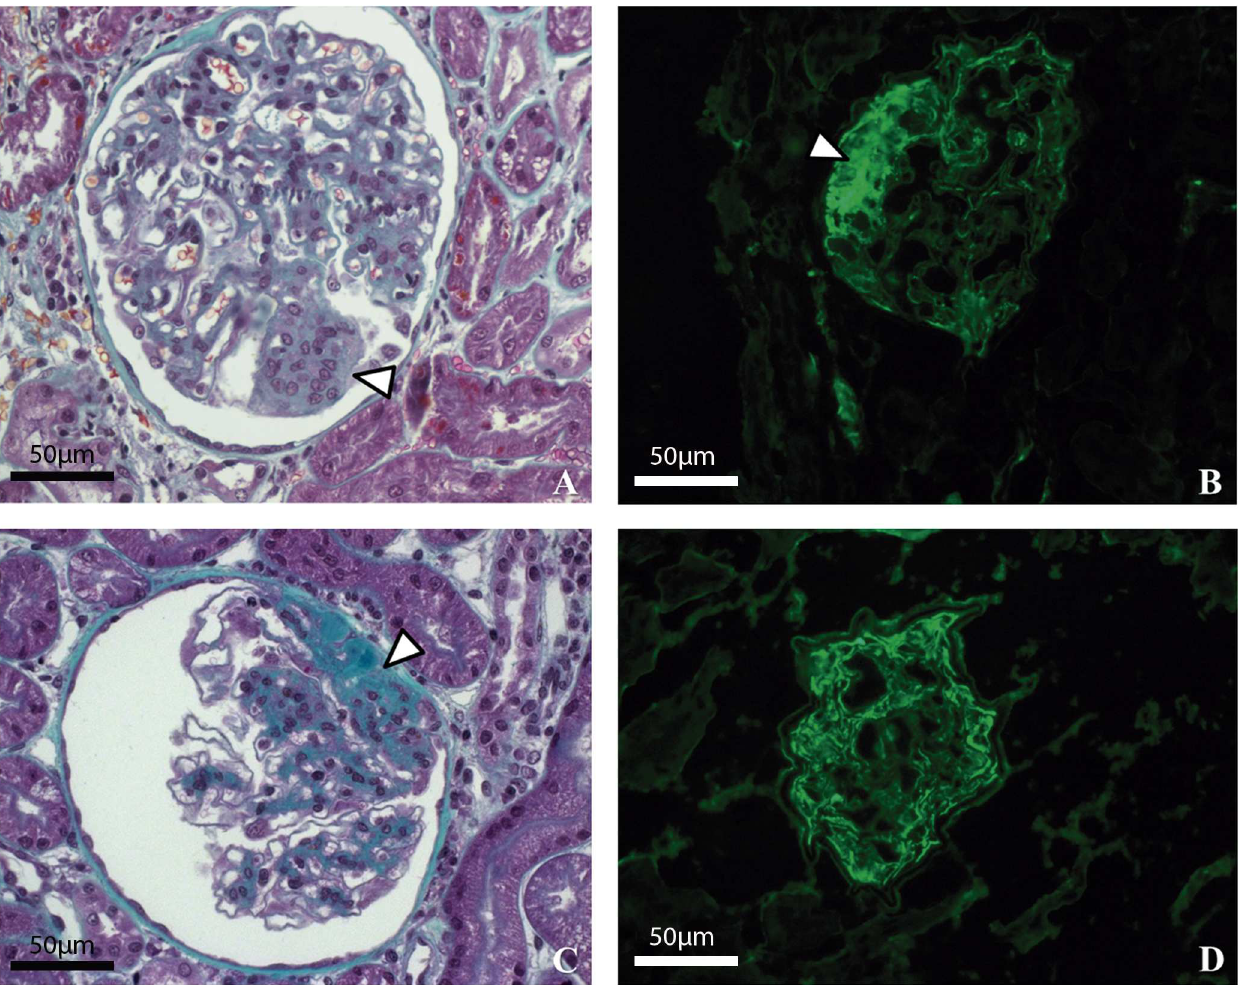
Fig 1. Microscopic findings in 2 dogs with mammarycarcinoma. (A) Focal segmental glomerulosclerosis and mesangial cell proliferation (arrowhead). Masson’s trichrome (B) Moderate diffuse granularpositivity for IgM in mesangium associated with trapping in a sclerotic segment (arrowhead). (C) Segmental sclerosis lesion with synechiae(arrowhead). Masson´s trichrome (D) Strong diffuse granularpositivity for IgM in mesangiumwith some extensions along the capillary loop. Magnificationx400.